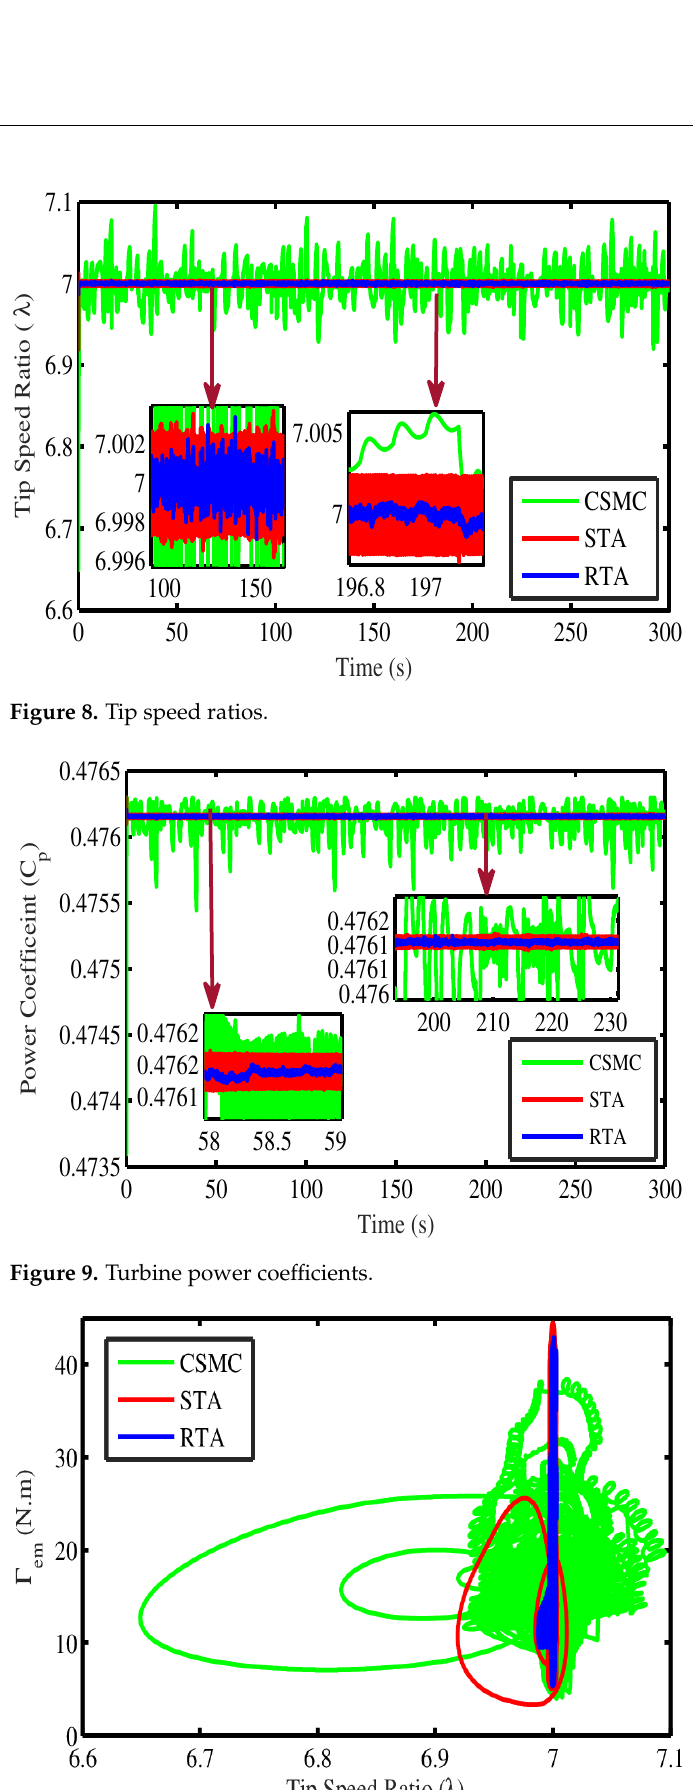
Figure 10. Electromagnetic torque versus tip speed